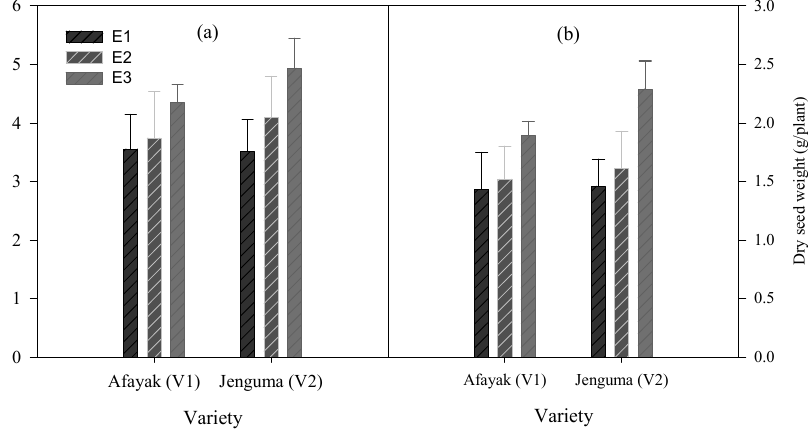
Figure 4. Environmental effect on ( a ) pod weight and ( b ) dry seed weight of both soybean varieties.